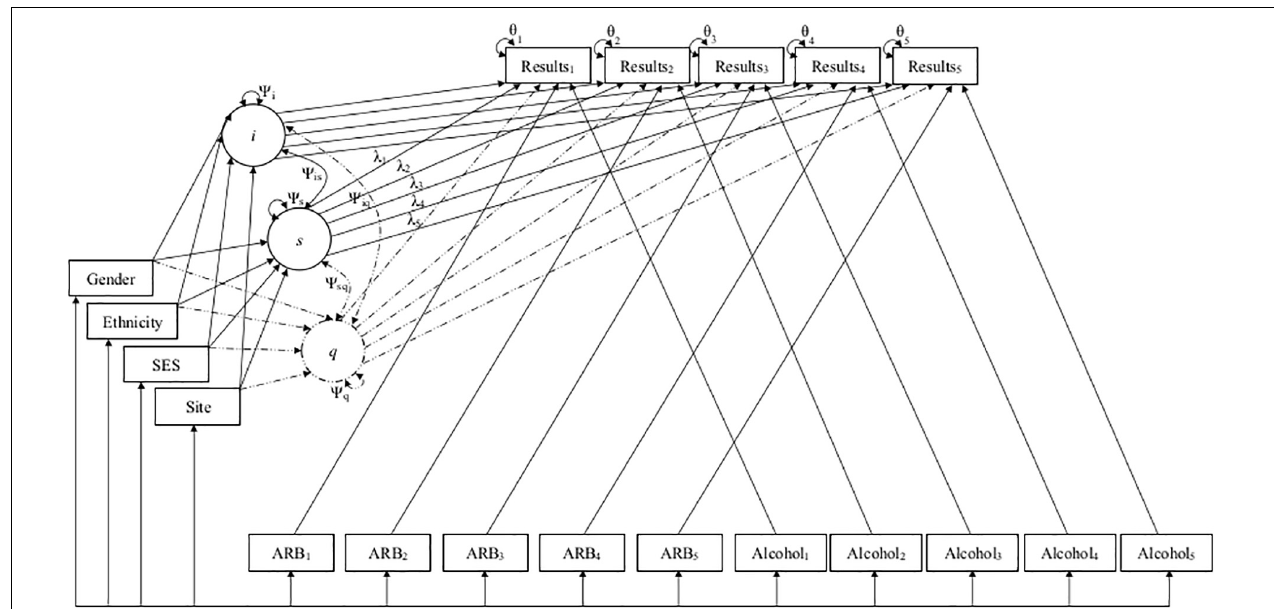
FIGURE 2 | Path diagrams for linear and quadratic conditional models. This figure depicts the path diagrams for linear and quadratic growth models, with solid lines depicting the original linear model and dashed lines representing additional parameters added to create the final quadratic model. Linear and quadratic models estimated the latent intercept ( i ), linear slope ( s ), and quadratic slope ( q ) growth factors to predict how individual and group characteristics (i.e., demographics and past-year alcohol use frequency and ARB history) impacted development of cognition across five timepoints. Growth factors i , s , and q are depicted in circles along with their variances ( Ψ i , Ψ s , Ψ q ) and co-variances ( Ψ is , Ψ iq , Ψ sq ). Demographics are included as time-invariant covariates (TICs) in boxes on the left of the figure. Time was parameterized using age as individually varying times of observation ( λ 1-5 ). ARB history (ARB 1 − 5 ) and alcohol use frequency (Alcohol 1 − 5 ) are included as time-varying covariates (TVCs) in boxes at the bottom of the figure. Observed neuropsychological test scores (Results 1 − 5 ) and their residual variance ( θ 1-5 ) at each time point are included in boxes at the top of the figure.